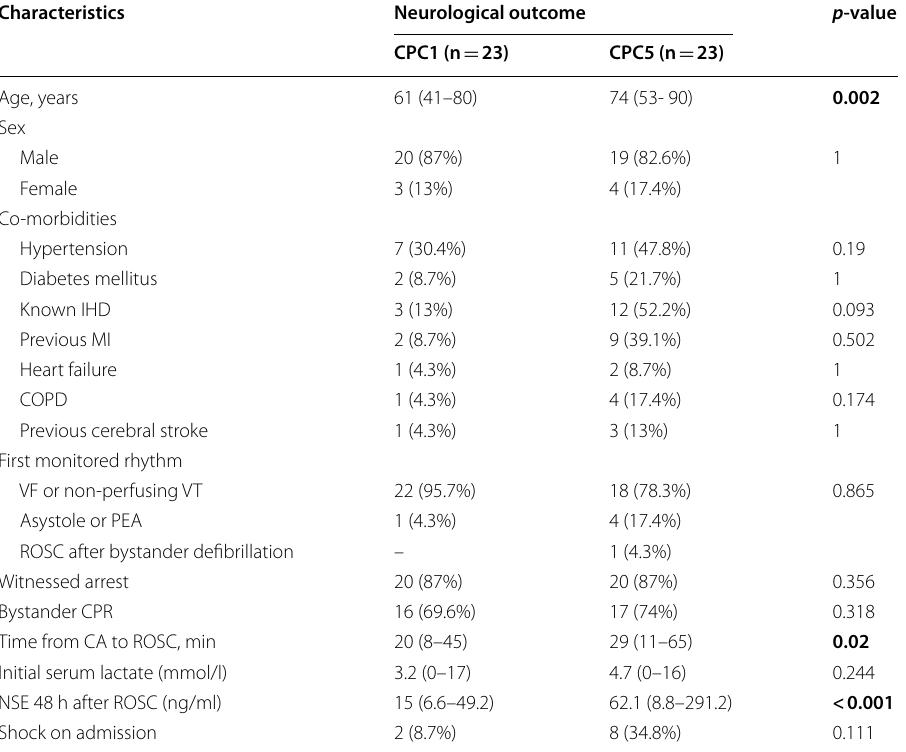
Table 1 Demographic and clinical characteristics of the discovery cohort